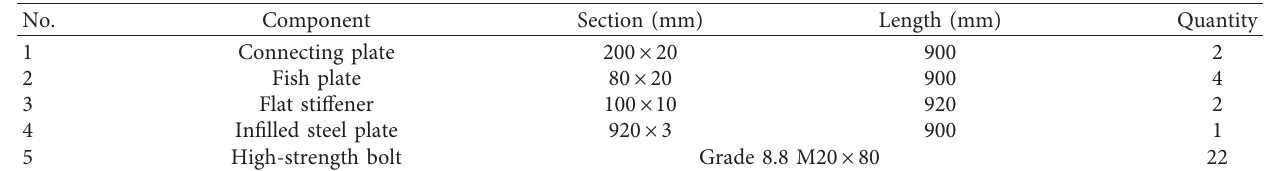
Figure 7: Construction of BRSPSW specimen. (a) Plan. (b) Side profile. (c) Top profile. (d) Infilled steel plate. (e) Concrete slab. (f) Fish plate. (g) Angle steel stiffener. (h) Photograph of BRSPSW specimen. Table 4: Components of SPSW specimen.